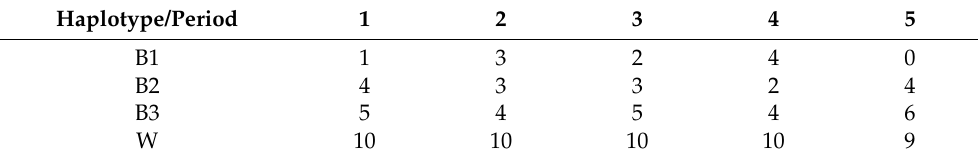
Table 3. Number of individuals per haplotype and period obtained from experiment 1.